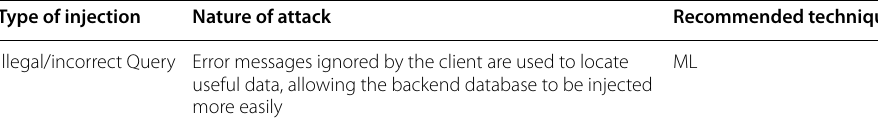
Table 4 Illegal or incorrect query [54] Type of injection Nature of attack Recommended technique